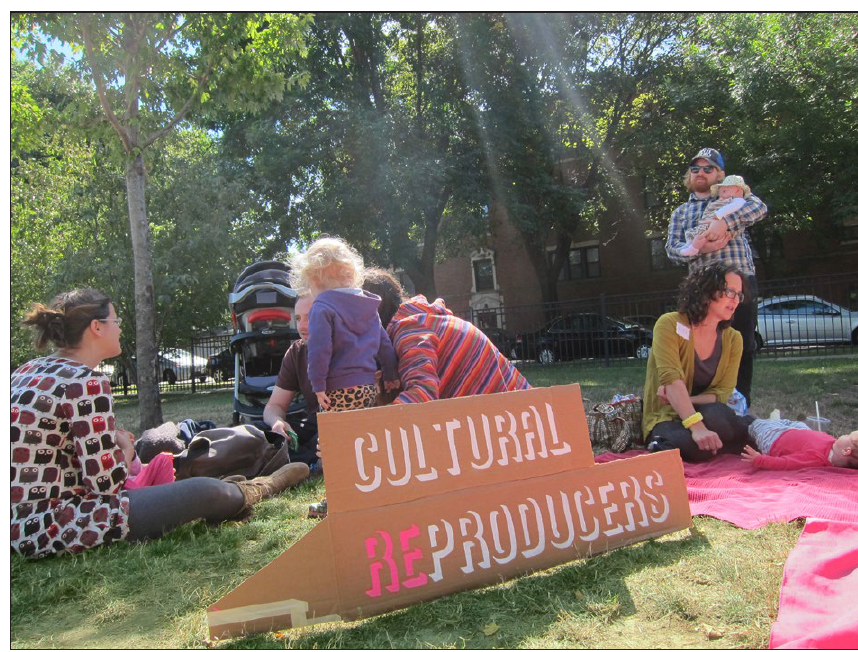
Figure 1: One of Cultural ReProducers’ first meetings in a local park, Chicago, IL, 2013. image: Christa